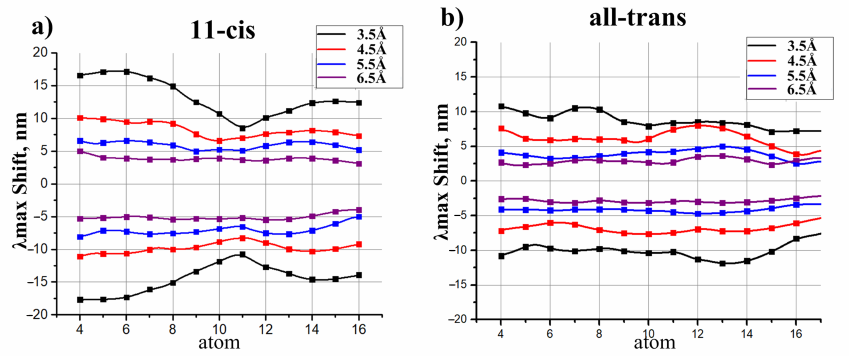
Figure 7. Largest possible negative and positive contributions of dipole moments to λ max of 11-cis PSB ( a ) and all-trans PSB ( b ) as functions of a dipole moment position along the chromophore axis. Functions were calculated at different distances of the dipole moment from the chromophore. Dots represent the ab initio calculated values. Functions were derived as the spline interpolation of the calculated